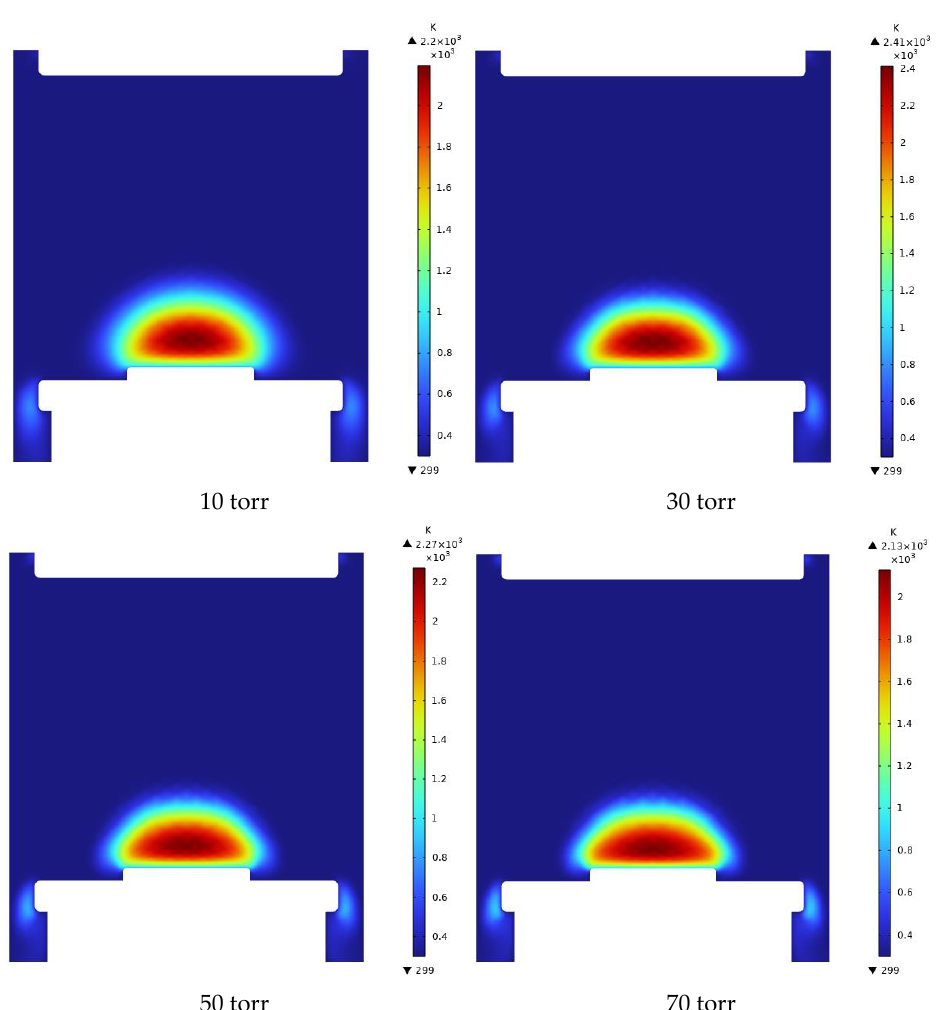
Figure 10. Contour plots of temperature distribution in the deposition chamber (K).